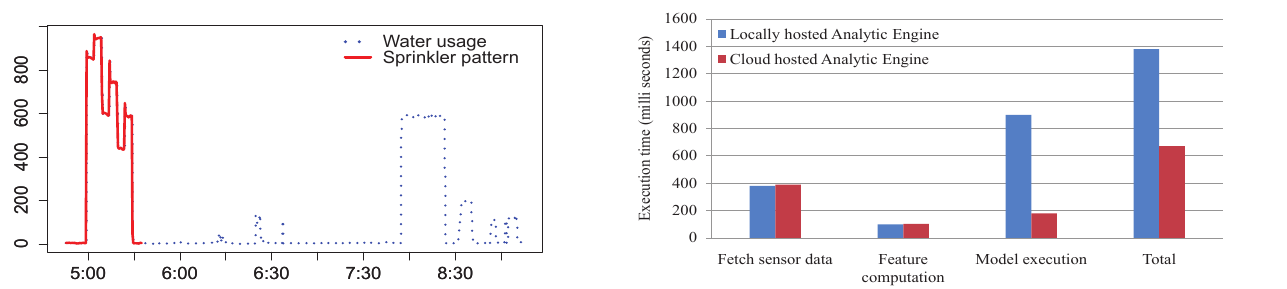
Figure 6: Comparison of execution time between local and cloud hosted analytics engine for the energy forecasting